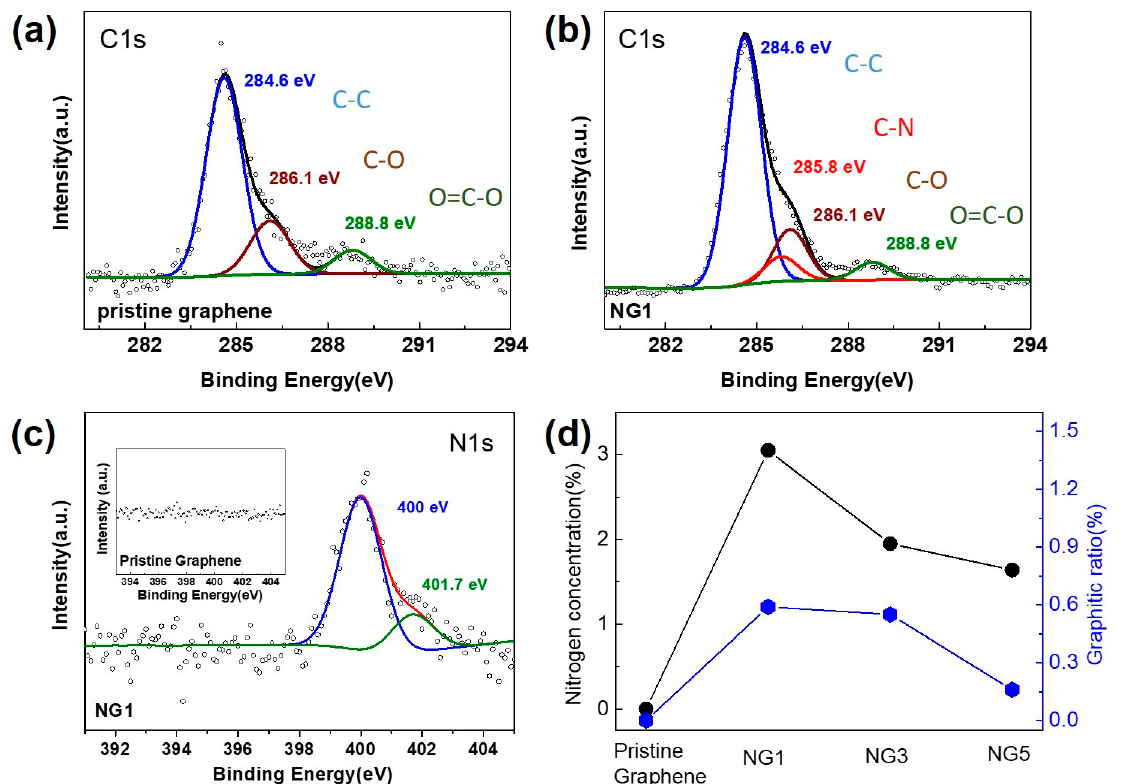
Figure 3. Analysis of X-ray photoelectron spectroscopy (XPS) spectra for pristine graphene and N-doped graphene. ( a , b ) C1s spectrum for pristine graphene and NG1; ( c ) N1s core level for NG1 (inset is the N1s spectrum for pristine graphene); ( d ) N content ratio and graphitic configuration ratio for NG1, NG3, and NG5.